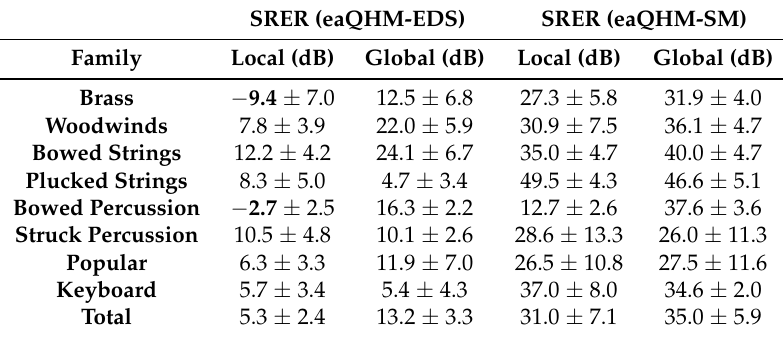
Table 2. Local and global difference of signal-to-reconstruction-error ratio (SRER) comparing eaQHM with exponentially damped sinusoids (EDS) and eaQHM with the standard sinusoidal model (SM) for the frame size L = 3 T 0 f s and number of partials K = K max . The three C2 sounds are not included. SRER (eaQHM-EDS) SRER (eaQHM-SM) Family Local (dB) Global (dB) Local